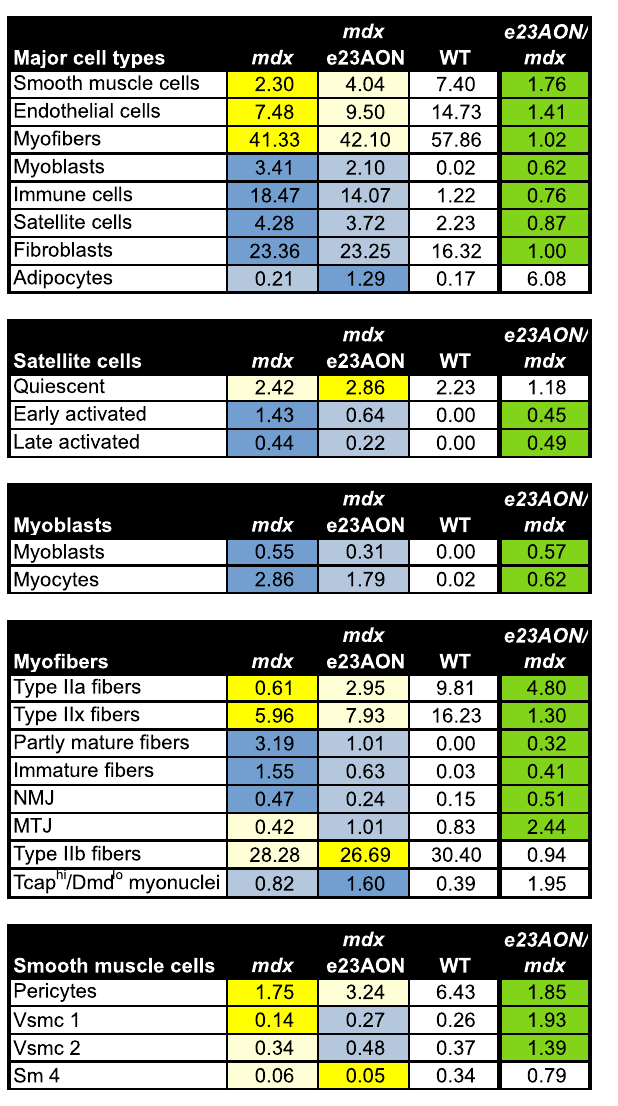
Fig. 2 Frequencies of intramuscular cell populations in WT and mdx mice and partial normalization of most populations in response to e23AON treatment of mdx . Percentages of each cell population for each pooled treatment condition, mdx ( n = 4), mdx e23AON ( n = 4), WT ( n = 3). Following the major cell types, cell types are further broken down to their respective subclusters. Blue = increase in percentage relative to WT, Yellow = decreased in percentages relative to WT. Rightmost column shows the effect of e23AON treatment relative to mdx , green denotes that cell numbers of mdx treated with e23AON recovered a more WT